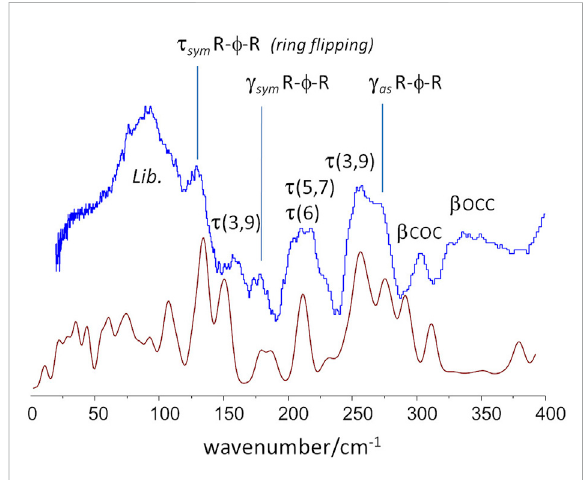
FIGURE 8 Low-wavenumber region of the INS spectra of PBF: experimental (top, blue) and calculated (bottom, red) for the aa- gtg crystal